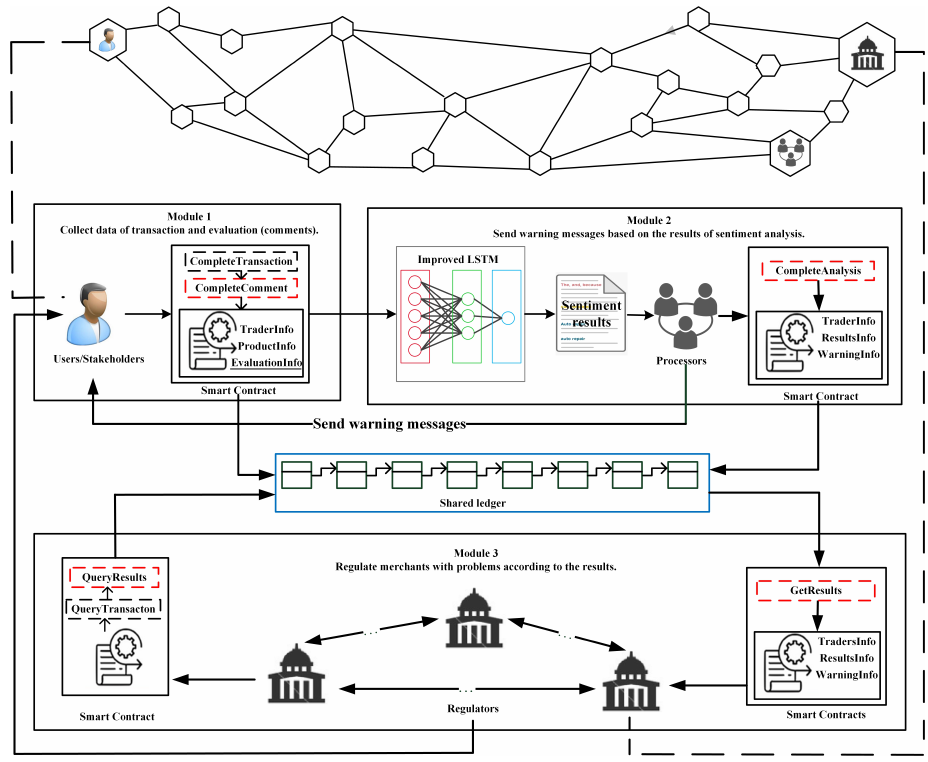
Figure 1. The framework of the proposed